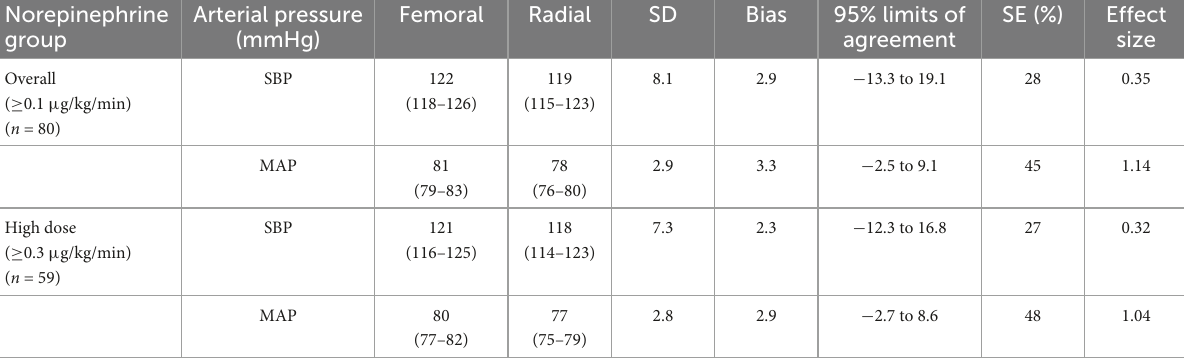
TABLE 4 Bias (mean of the difference) and 95% limits of agreement between arterial pressure measurements at the femoral and radial arterial sites, calculated via Bland–Altman analysis accounting for repeated simultaneous measurements. Norepinephrine Arterial pressure group